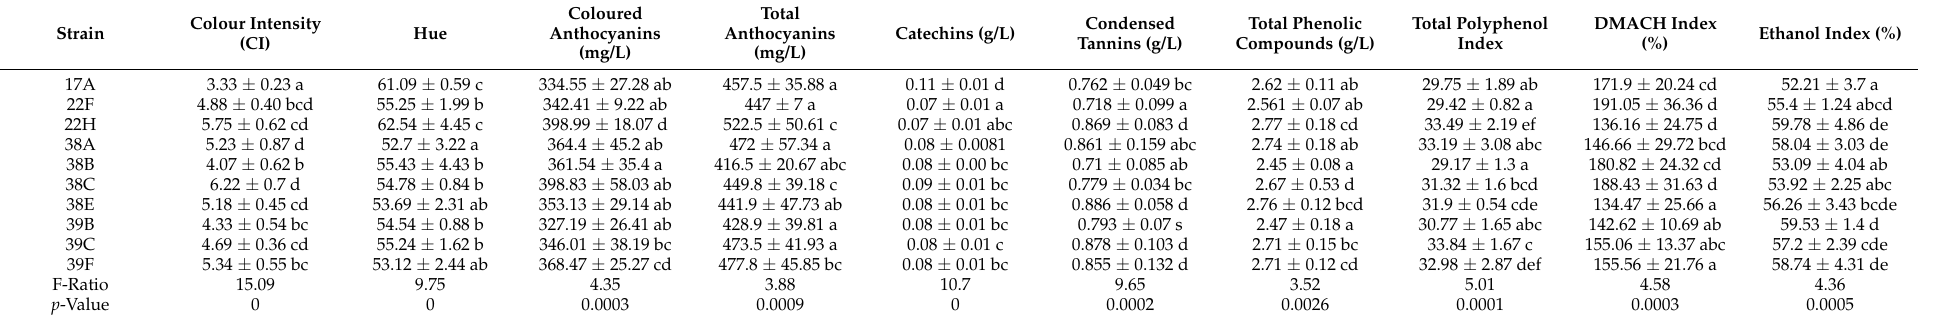
Table 3. Effect of fermentation with the selected yeasts on the phenolic compounds of Garnacha wines.